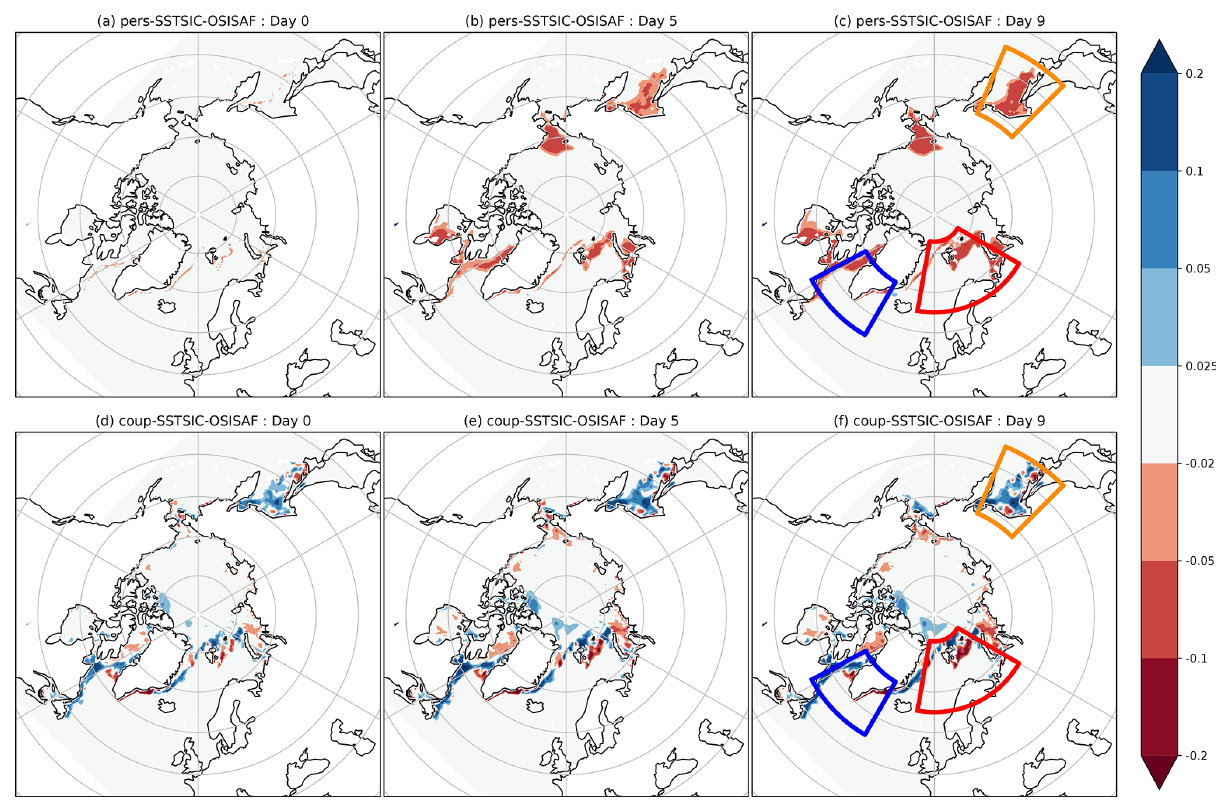
Figure 1. Daily mean sea ice concentration bias, relative to OSI SAF for the persisted forecasts, pers-SSTSIC (a–c) , and the coupled forecasts, coup-SSTSIC (d–f) , at a lead time of 0d (a, d) , 5d (c, e) and 9d (e, f) . The Nordic Seas (red), Labrador and North-East Atlantic region (blue), and Sea of Okhotsk (orange) are highlighted by the coloured boxes in the right-hand